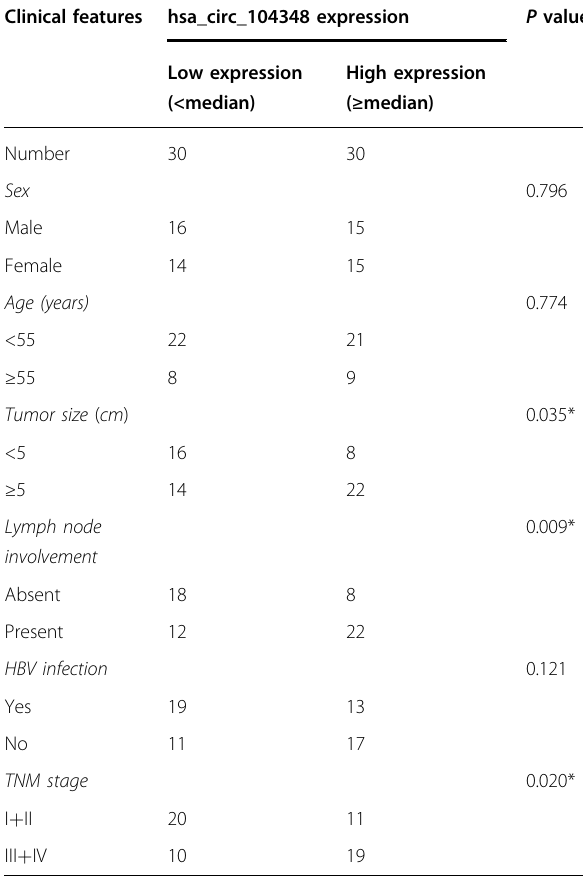
Table 2 Association between clinical features and hsa_circ_104348 expression of hepatocellular carcinoma